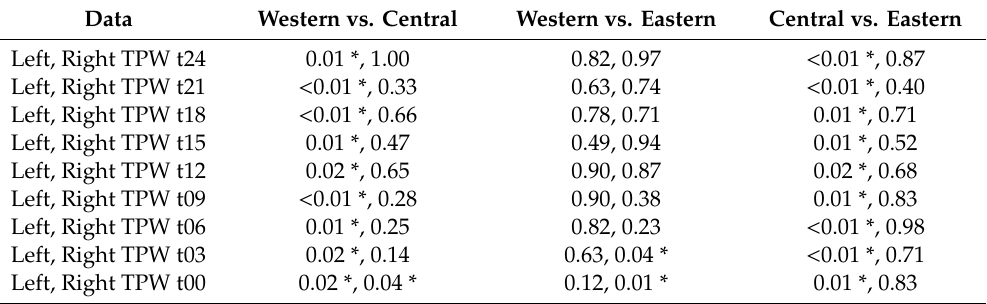
* Groups tested are significantly di ff erent at α =